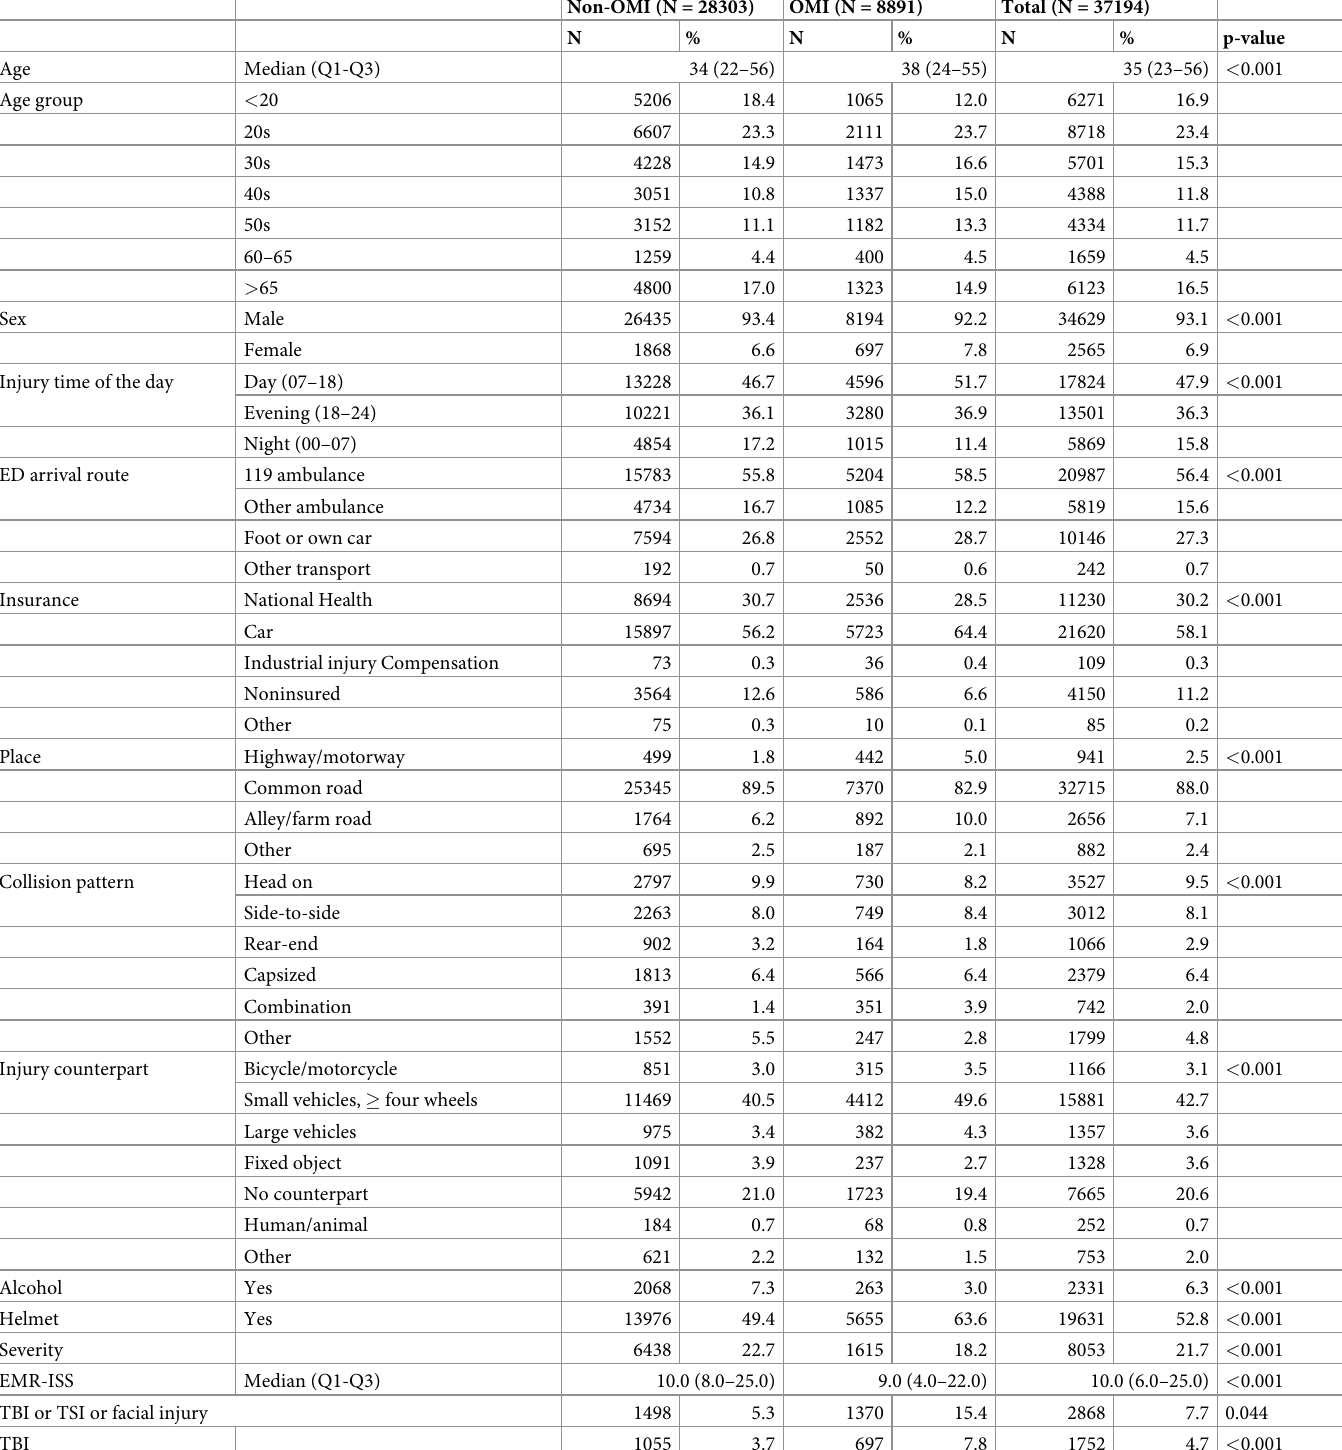
Table 1. General characteristics, demographic characteristics, injury details, and clinical results of motorcycle injury cases in the study period, according to the occupational or non-occupational